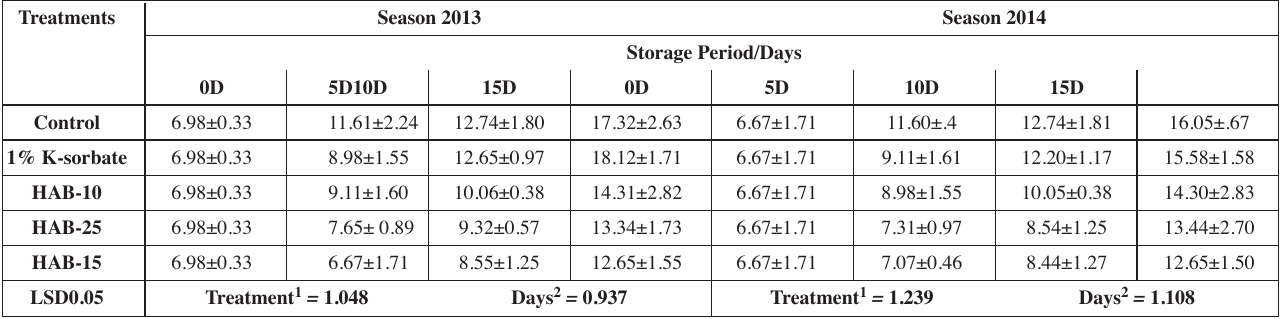
2B= Season 2014 Fig. 2B: Effect of fluorescent Pseudomonas species on decay percent of 2B= Season 2014 tomato stored at 23±4 ºC with relative humidity in the range of 25%-70%. 2B = Season 2014, LSD 0.05 = Treatment 1 = 8.7, Days 2 = 7.8 1 Mean values of bar in graph for treatment showing differences greater than LSD values are significantly different at p<0.05 2 Mean values of bar at different days in graph showing differences greater than LSD values are significantly different at